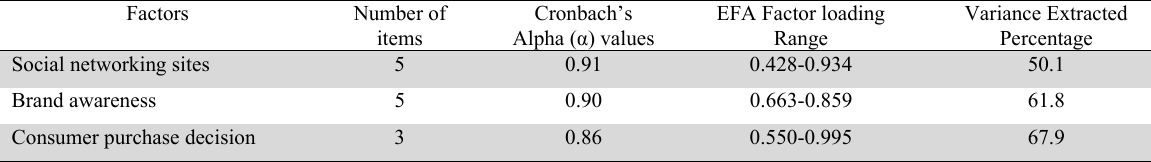
The results of Exploratory factor analysis (EFA) among different factors